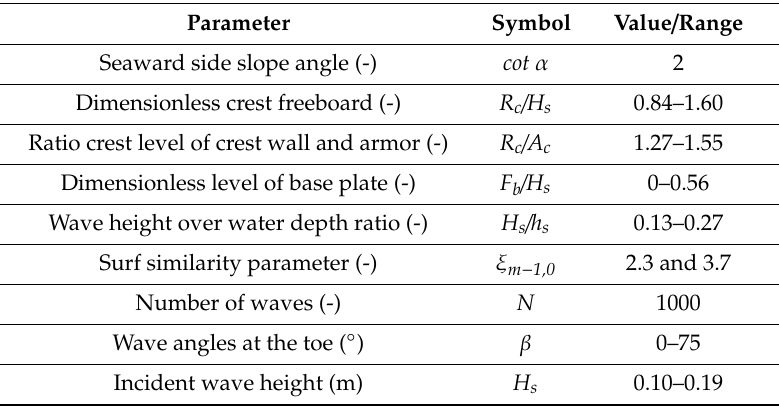
Table 1. Summary of the parameter ranges of the test